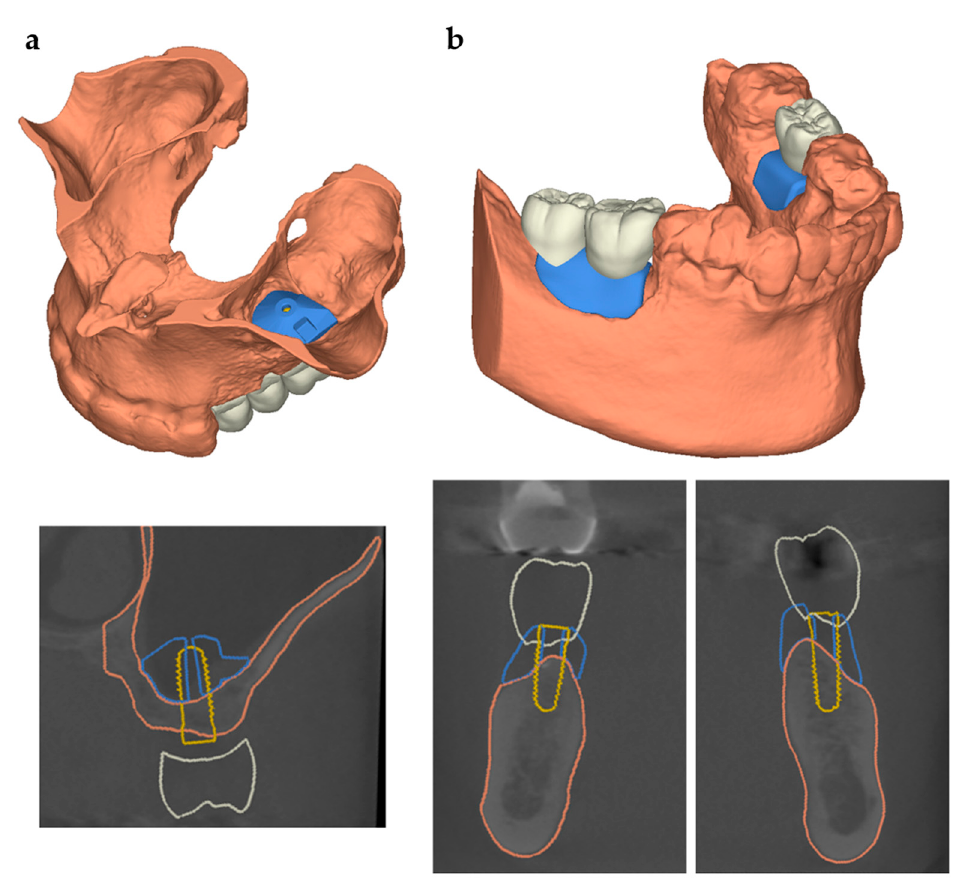
Figure 8. Digital backward planning based on CBCT data. ( a ) Sinus floor elevation in region 26, ( b ) bilateral onlay graft in the posterior mandible (white: prosthetic restoration; yellow: dental implant; orange: bone contour; blue: planned CPC scaffold.